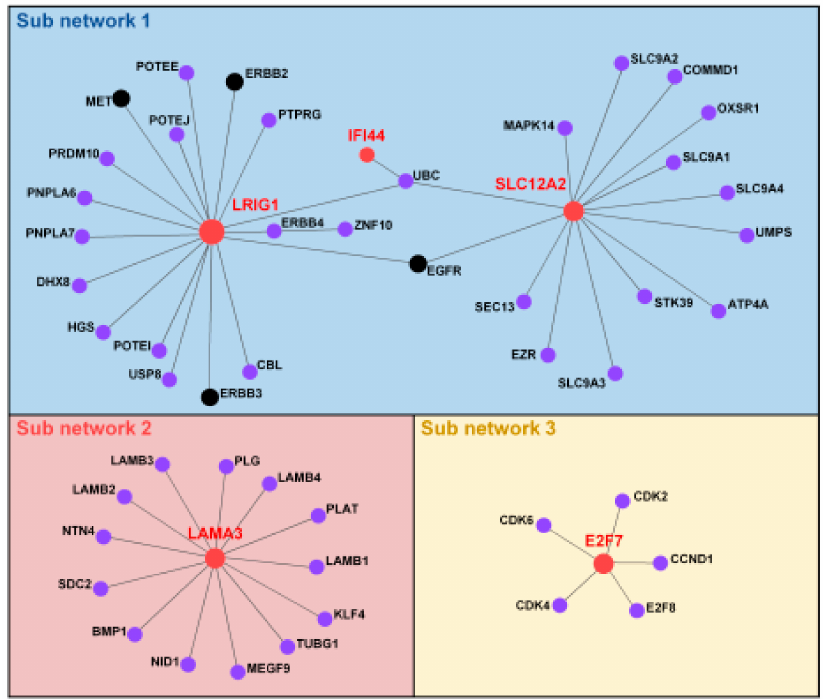
Figure 10. Protein–protein interaction network analysis of the PAC-5 genes. Interaction map was generated using the STRING database with experimental evidence in the Network Analyst 3.0. The proteins of the PAC-5 signature were red-circled, and the proteins related to the term of EGFR inhibitor resistance in KEGG pathway were